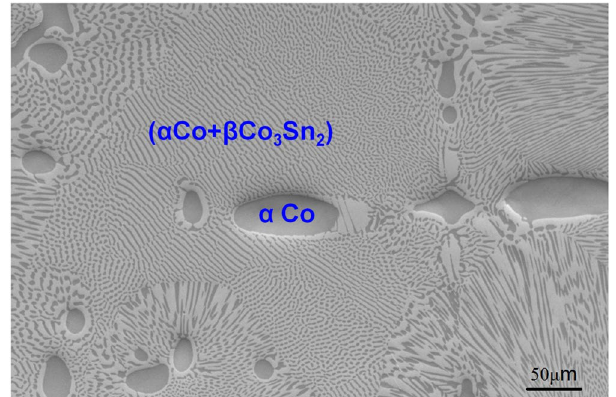
Figure 1. Typical microstructure of Co 76 Sn 24 near eutectic alloy solidified without magnetic field at low undercooling. The microstructure shows typical hypoeutectic solidification with a small amount of primary α Co phase (dark phase) and lamellar eutectics of α Co (dark phase) + β Co 3 Sn 2 (white phase).